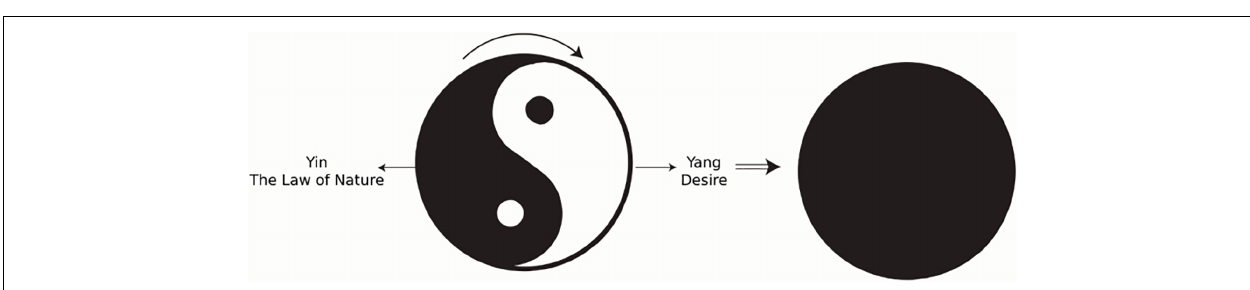
FIGURE 4 | Taoist mental health definition